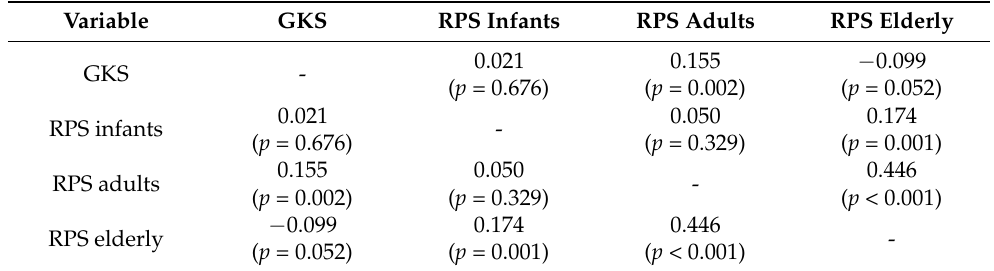
Table 2. Correlation between General Knowledge Score (GKS), and the Risk Perception Scores (RPS) for Respiratory Syncytial Virus (RSV) infections in infants, adults, and elderly. Spearman’s correlation test (rho) with their respective p